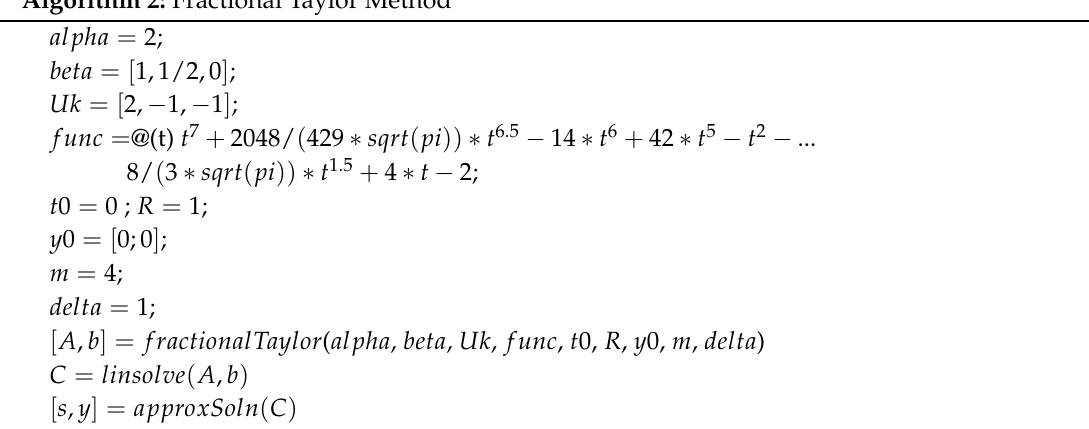
Algorithm 2: Fractional Taylor Method